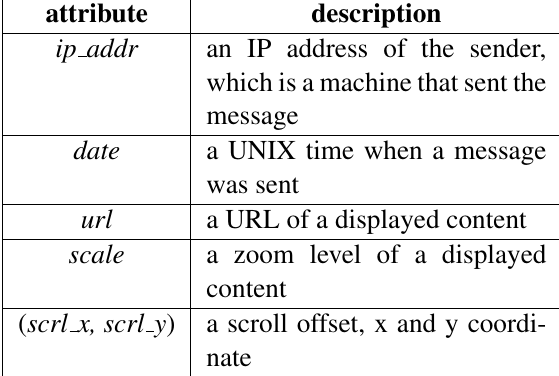
Fig. 5. Transform to coordinates of the device (0, 0) The attribute url , scale , and ( scrl x, scrl y ) de- scribe the state of displayed contents on the